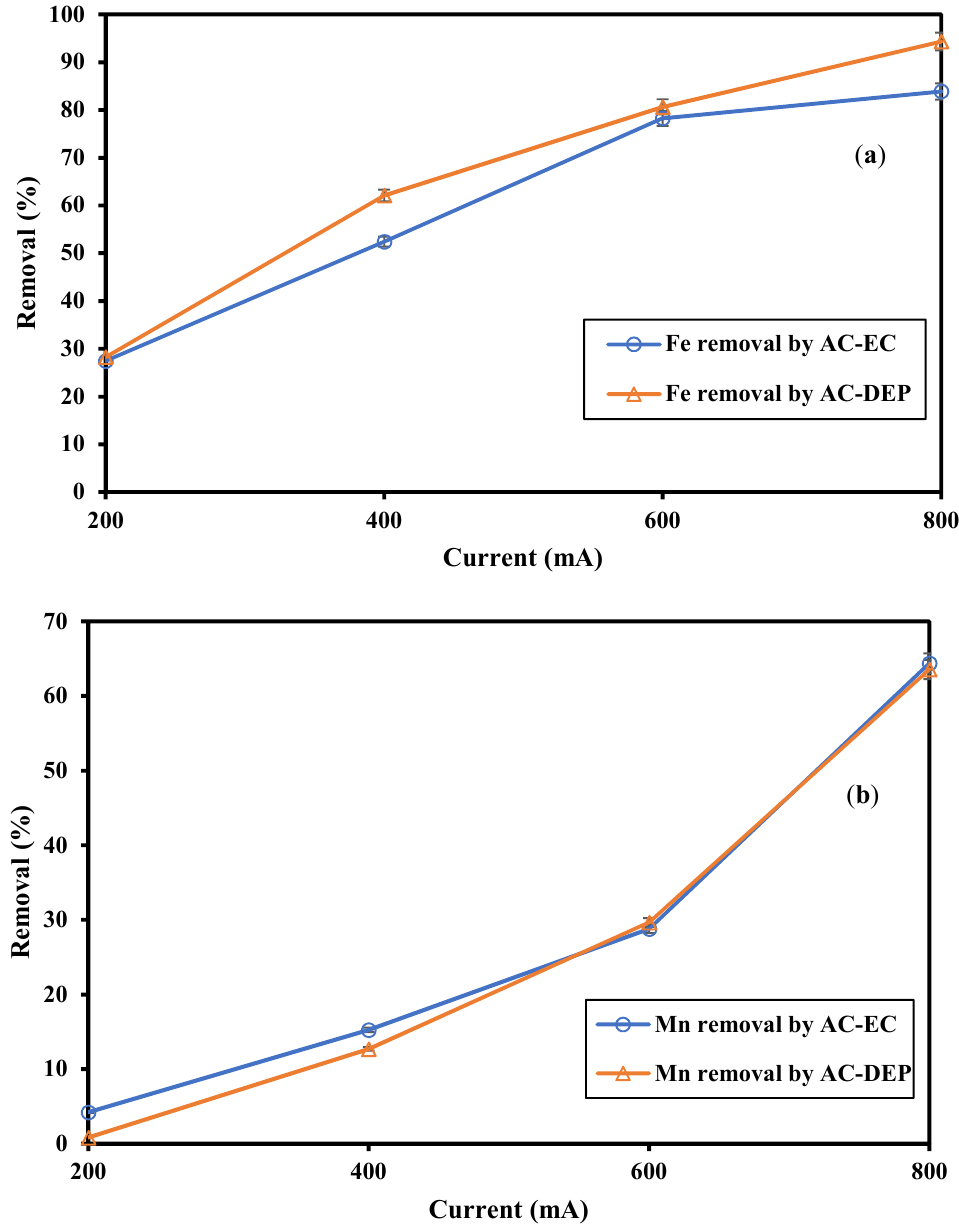
Figure 10. The removal percentage of Fe and Mn using variable applied current, electrolysis time 30 min and electrode spacing 0.5 cm. ( a ) Fe removal percentage; ( b ) Mn removal percent- age.